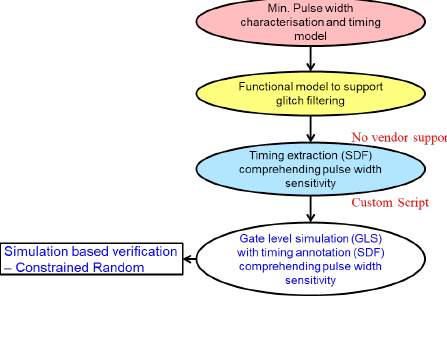
Figure 12. Design verification methodology